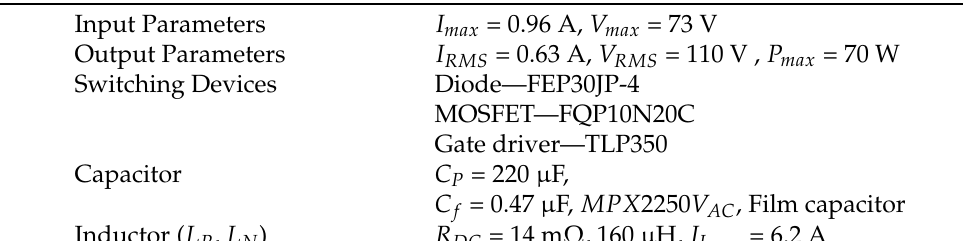
Table 6. Element values obtained from the design [5].